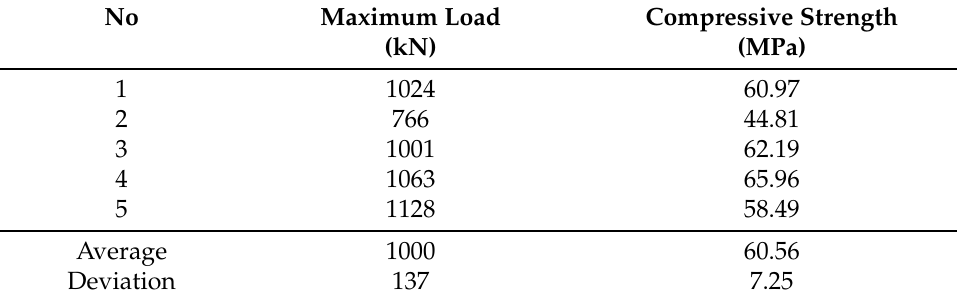
Figure 9. Brick compression test. ( a ) Before testing, ( b ) after testing—front view, ( c ) after testing— back side view. Table 3. Brick compressive strength